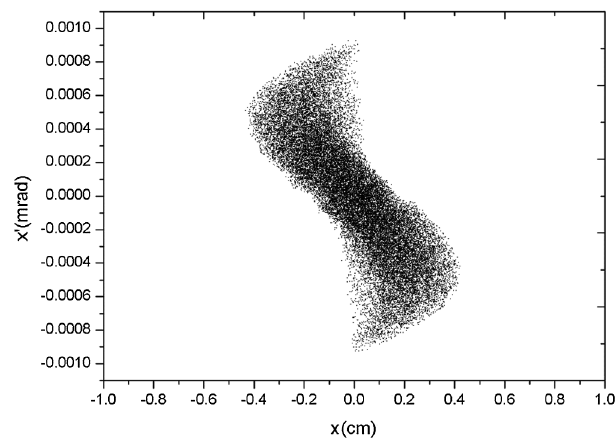
FIG. 6. Particle distribution in the horizontal phase space at the RFQ